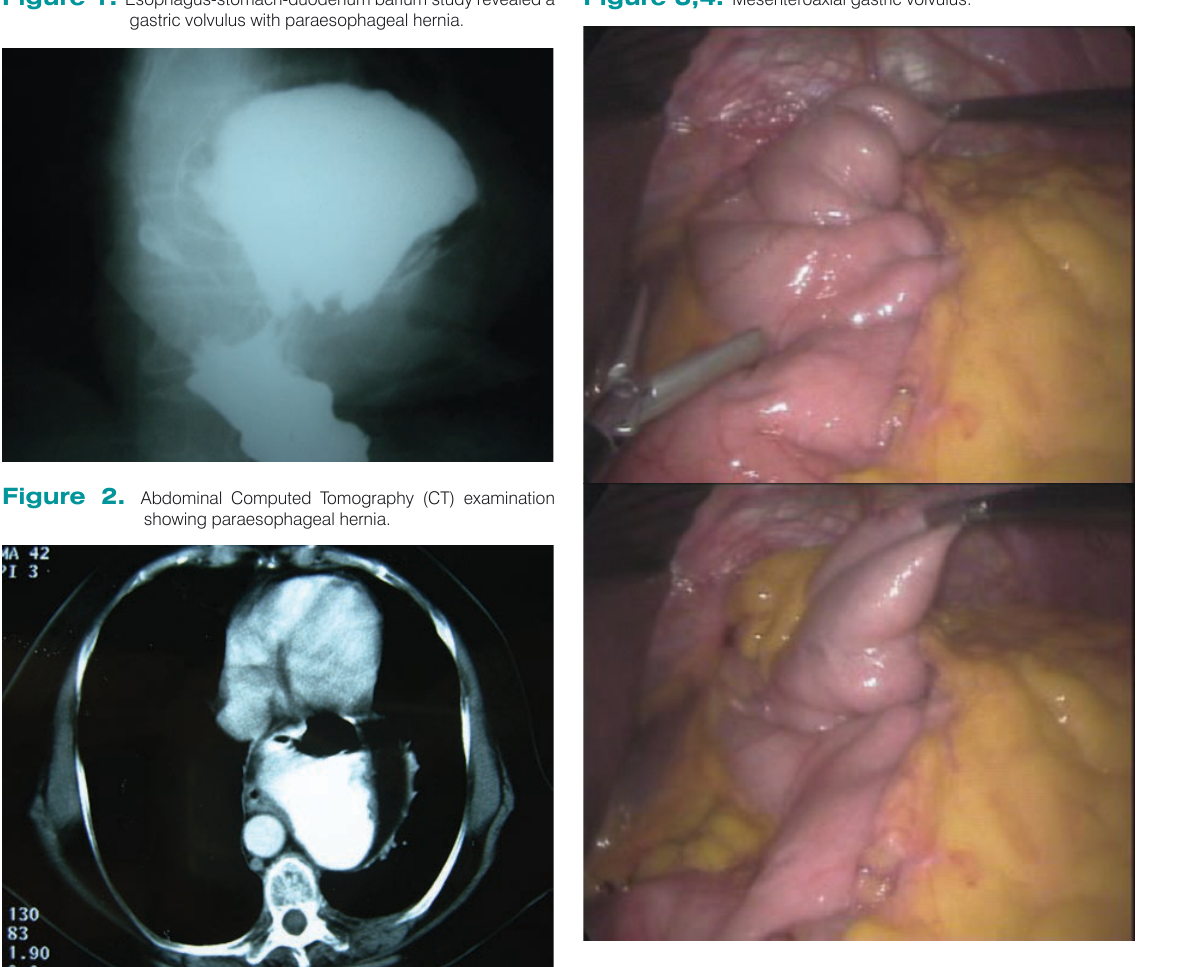
Figure 5. Large paraesophageal